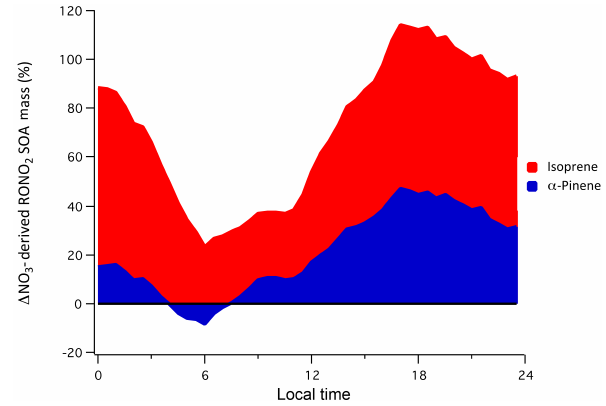
Figure 12. Diurnal profile of the net change in NO 3 -derived RONO 2 SOA above the canopy as a result of including transport between the above- and below-canopy